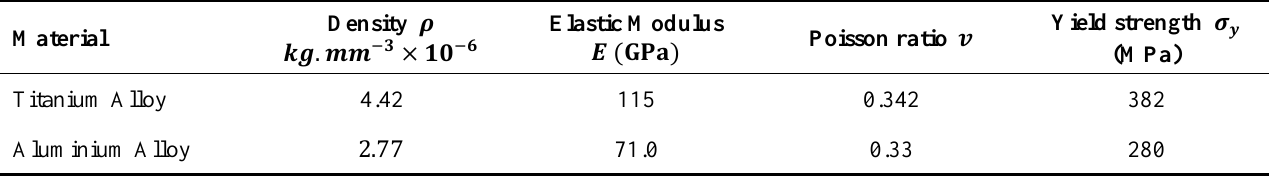
Table 1. Material properties of aluminum and titanium alloy used for the analysis of catenoidal horn